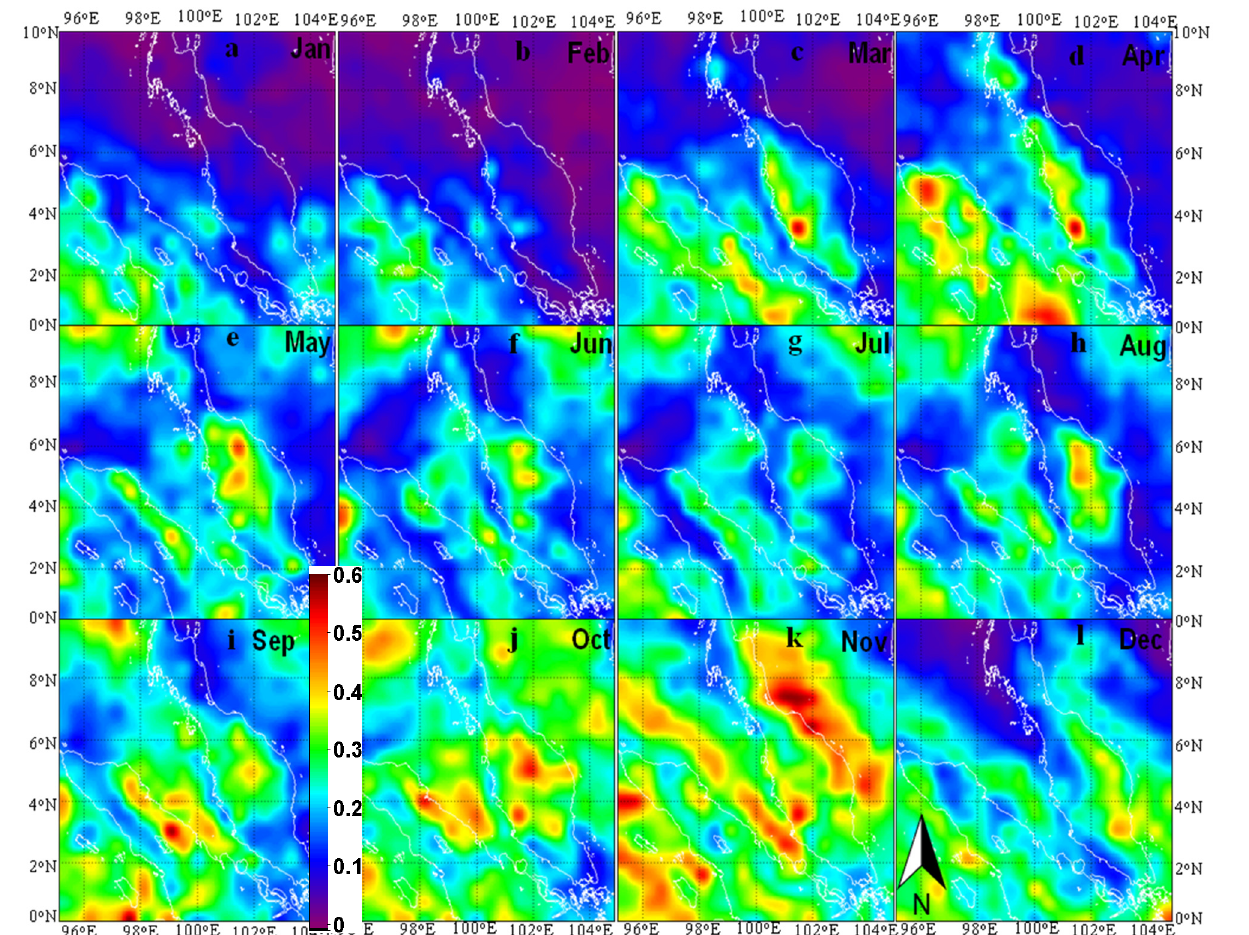
Figure 8. ( a – l ) Monthly climatological means of rain rate (RR, mm∙h −1 ) averaged from monthly TRMM RR retrieved within the period of the SeaWiFS full